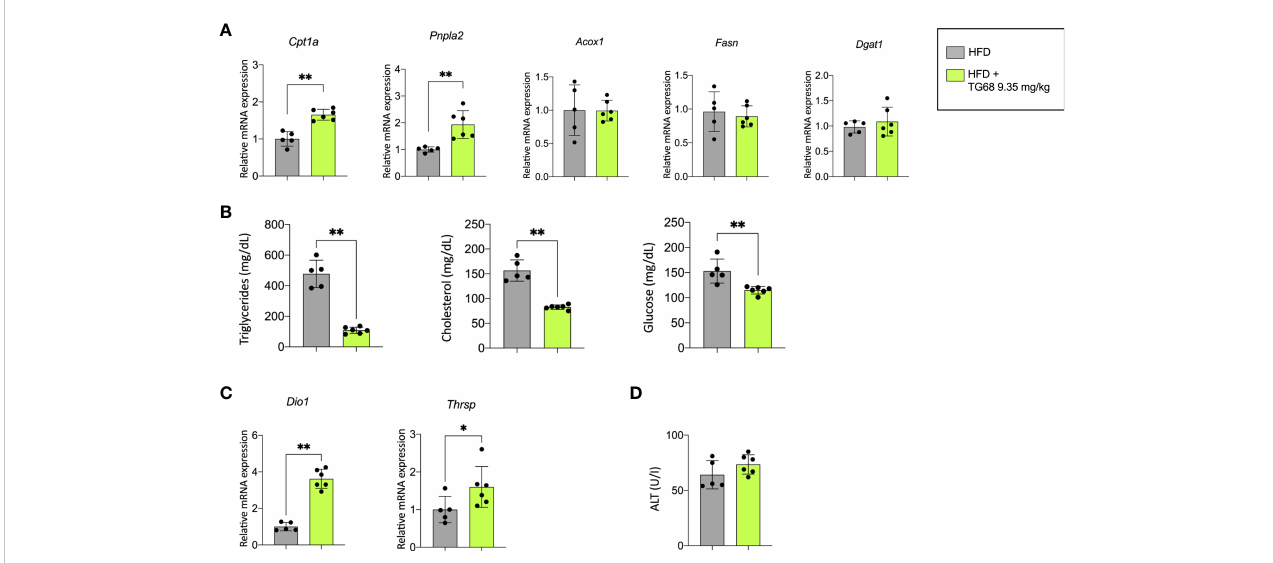
FIGURE 2 Effect of a three-week treatment with TG68 on lipid metabolism, serum triglycerides, cholesterol and glucose levels and mRNA levels of target genes of thyroid hormone receptor. (A) Gene expression analysis of Cpta1 , Pnpla2 , Acox1 , Fasn, Dgat1 in rat livers exposed to Experimental Protocol described in Figure 1A. Gene expression is reported as fold-change relative to livers from rats fed HFD alone; (B) Effect of TG68 on serum triglycerides, cholesterol and glucose levels; (C) Gene expression analysis of Dio1 and Thrsp in rat liver. Gene expression is reported as fold-change relative to livers from rats fed HFD alone; (D) Serum levels of Alanine aminotransferase (ALT). Groups were compared by student ’ s t-test. Values are shown as mean ± standard deviation of 5 to 6 rats/group. * p <0.05, ** p <0.01. HFD, high fat diet; ALT, alanine